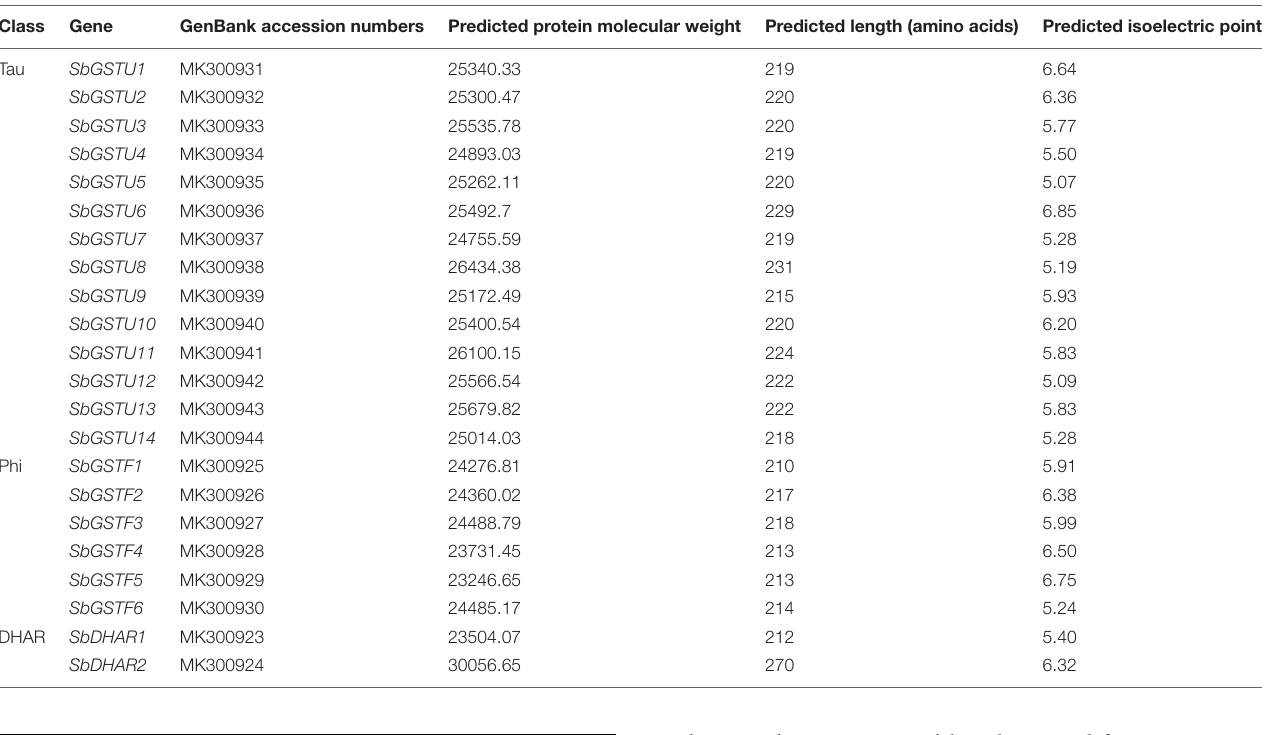
TABLE 1 | The GST genes cloned from Salix babylonica .